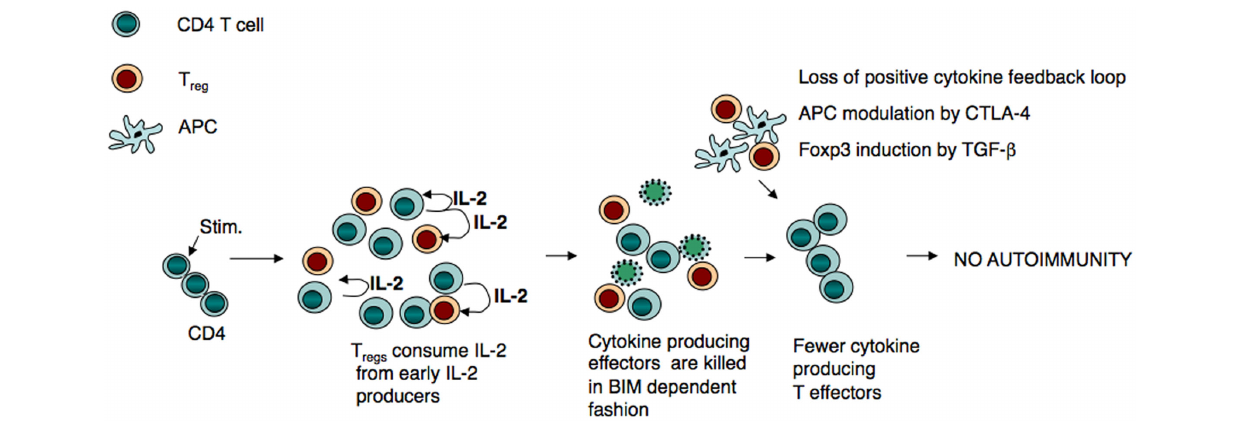
However, cells that are not in direct/close proximity toT reg5 , may remain in the system and continue to expand. Because of the low levels of IL-2 in their milieu and inactivation of APC by CTLA-4, their later effector function and cytokine production are impaired.This limits autoimmunity, perhaps under homeostatic conditions involving